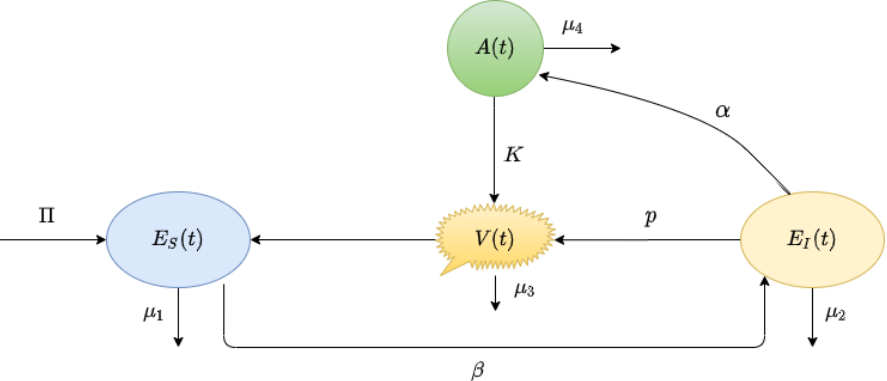
Figure 1. Conceptual diagram of Model (2). It shows the flowchart of antibody responses in SARS- CoV-2 infection within a